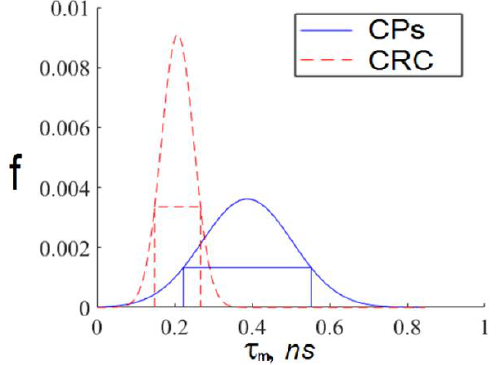
Figure 9. Interval approximations of the distribution functions of the short and long average TPAF lifetimes presented in Figure 8. These curves were calculated using Gaussian approximation of the data presented in Table 1. Notations on the legend: CPs — the exosome samples from the whole CRC patient group; CRC — the exosome samples from the whole CP patient group.